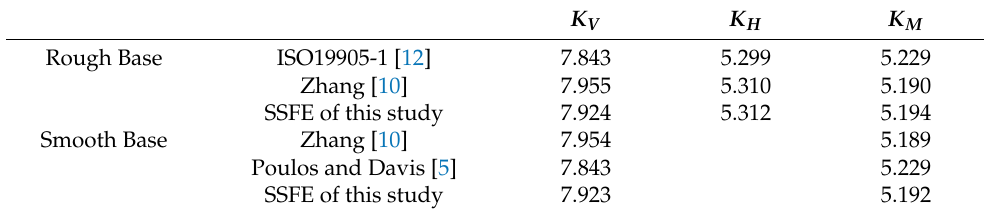
Table 2. Validation of the finite element model with existing solutions.